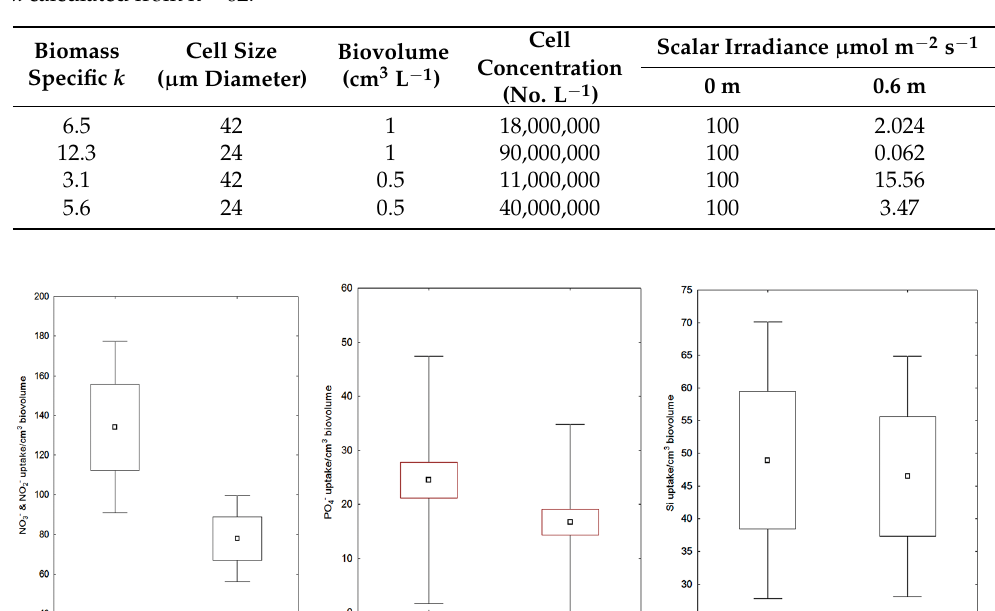
Figure 9. Biomass specific uptake of inorganic nutrients in the 300 m 3 reactor 2018–2021. Inner boxes = Mean +/ − S.E. and outer whiskers = Mean +/ − 0.95 confidence intervals. Left nitrate and nitrite, n = 117 and students t -test p = 0.041. Middle Orthophosphate, n = 127 and students t -test p = 0.66. Right Metasilicate, n = 95 and students t -test p = 0.86.